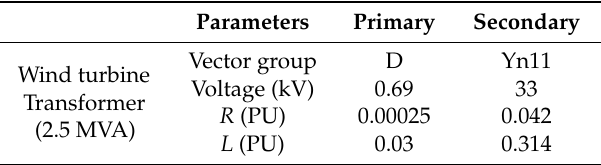
Table 5. Wind turbine transformer data.